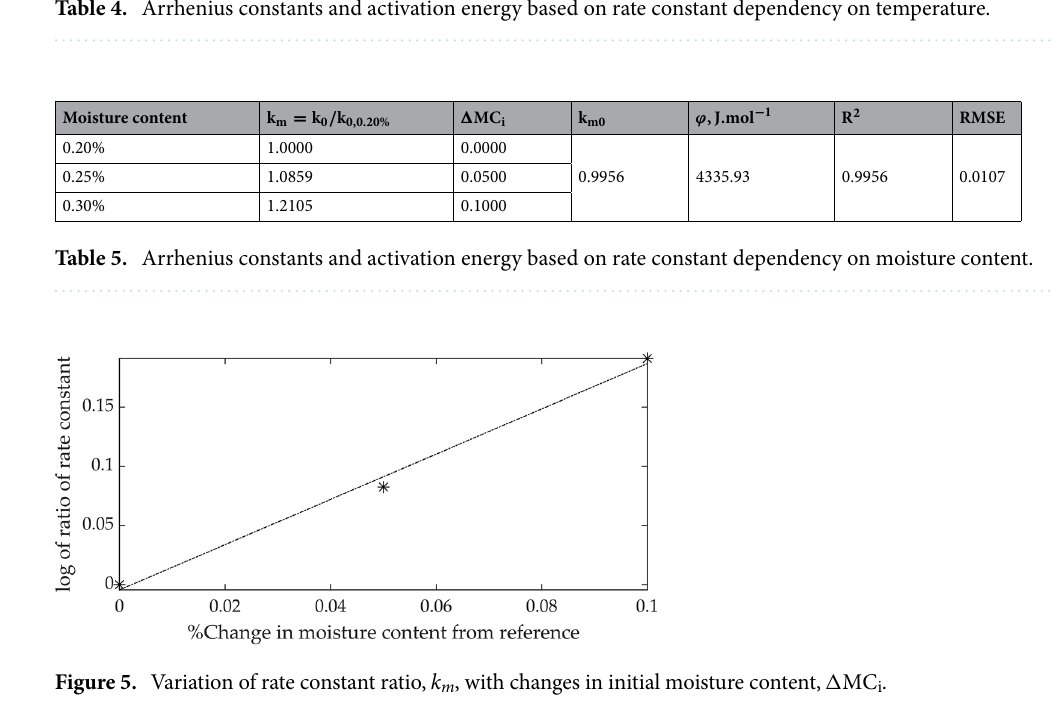
Table 4. Arrhenius constants and activation energy based on rate constant dependency on temperature.